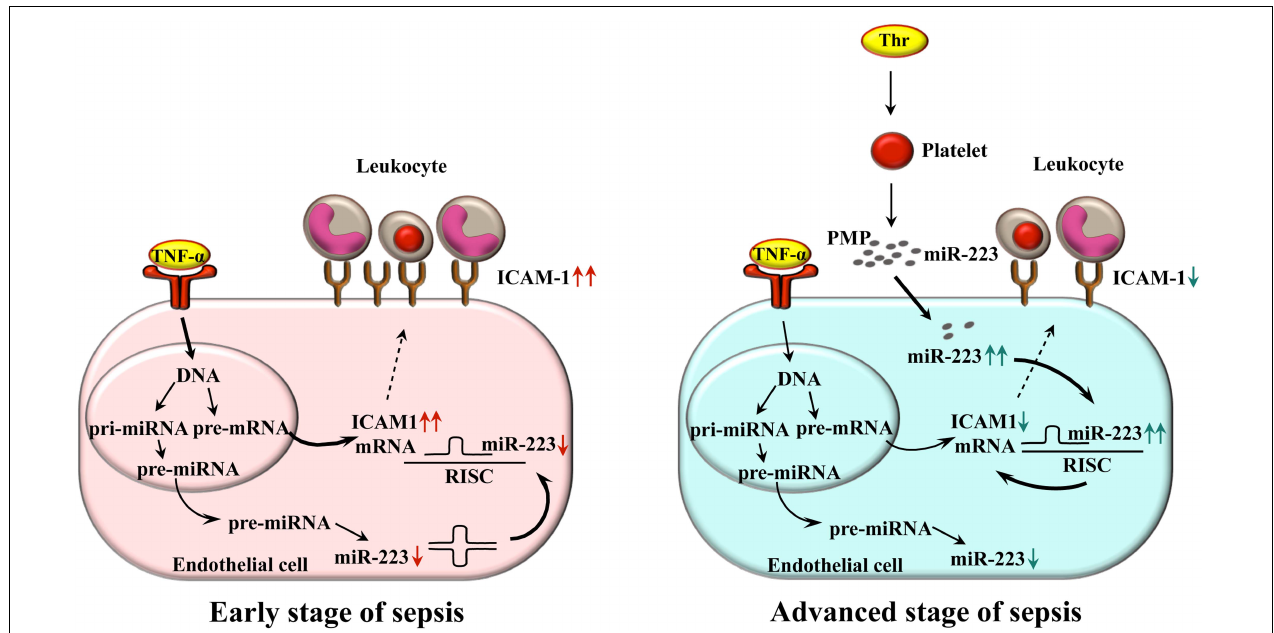
FIGURE 7 | Schematic figure about the working model on the delivery of miR-223 by PMPs to endothelial cells to downregulate ICAM-1 expression and leukocyte adhesion in septic conditions. Inflammation triggered endothelial cells express elevated level of ICAM-1 on their surface in the early stage of sepsis (left panel). During the propagation of the disease, thrombin-stimulated platelets release a large amount of PMPs transferring miR-223 to different recipient cells. After the uptake by the endothelium, inflammation-induced ICAM-1 expression is reduced, which also limits leukocyte adhesion, acting as a protection against excessive sepsis-related vascular inflammation (right panel). Bold arrows depict the major signaling pathway in each stage of sepsis that affects ICAM-1 expression. ICAM-1, intercellular adhesion molecule-1; Thr, thrombin; TNF- α , tumor necrosis factor alpha; PMP, platelet microparticle; RISC, RNA-induced silencing